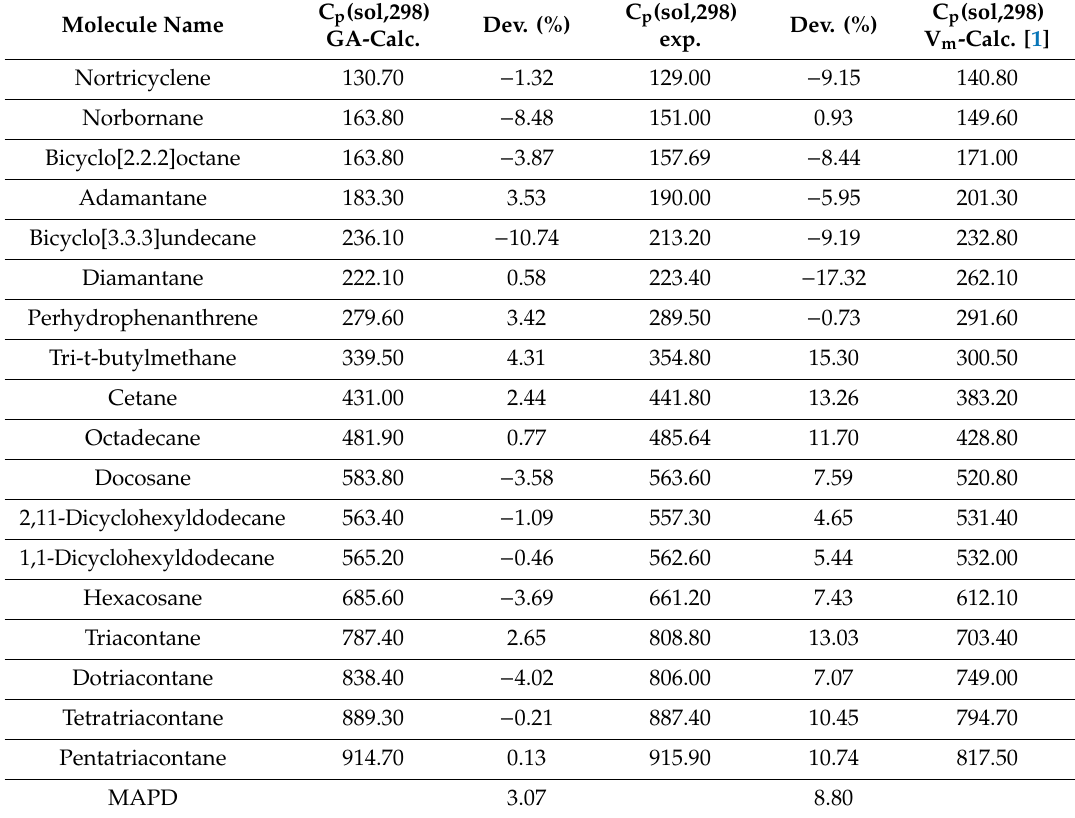
Table 9. Experimental C p (sol,298) data of 18 alkanes and cycloalkanes, compared with prediction values calculated by the present GA and the V m [1] method (in J / mol / K). Molecule